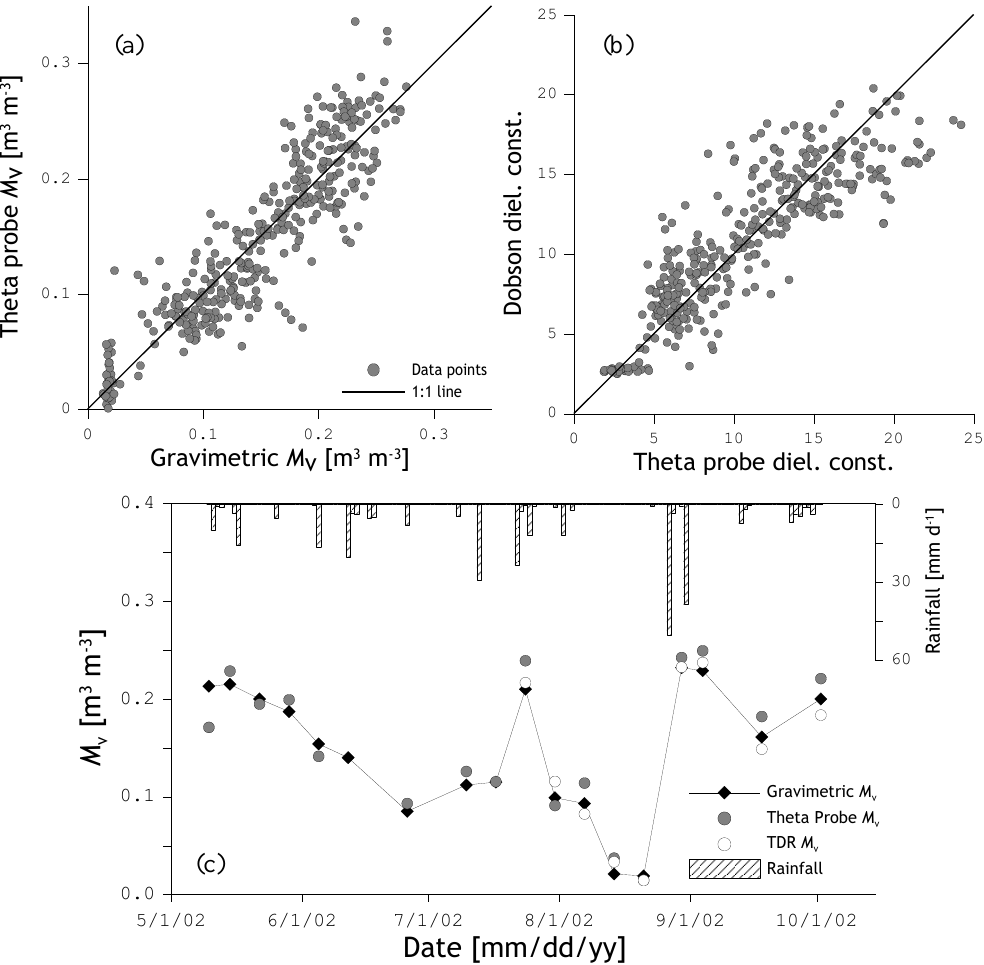
Figure 2. (a) Comparison of the calibrated theta probe against the gravimetric M (b) Comparison of the theta probe measured ε Dosbon soil mixing model; (c) M sampling technique plotted against